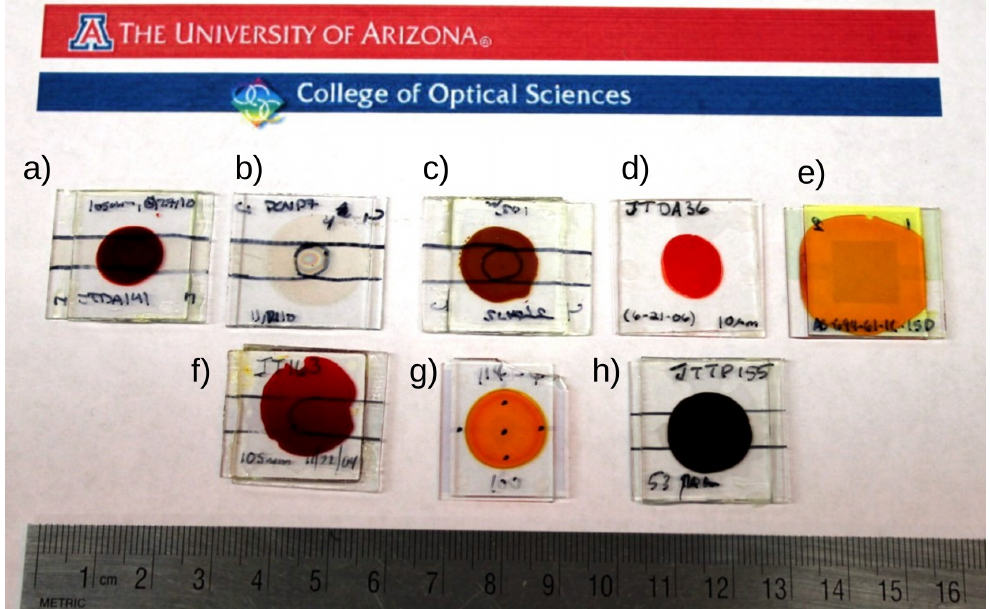
Figure 4. Picture of various photorefractive samples illustrating the different absorption the samples can exhibit: ( a ) PVK:DHADC-MPN [42], ( b ) PVK without chromophore, ( c ) PVK:TNF:DMNPAA [69], ( d ) PVK:DR1 [70], ( e ) PATPD:FDCST [32], ( f ) PATPD:7DCST:DBM [43], ( g ) PATPD:7DCST:AlQ3